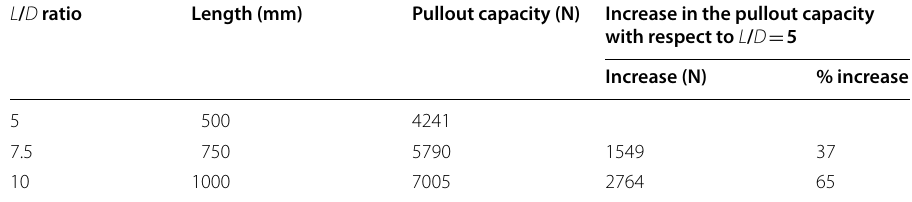
Table 5 Effect of the L / D ratio on the pullout capacity of a 100 mm diameter single GPA